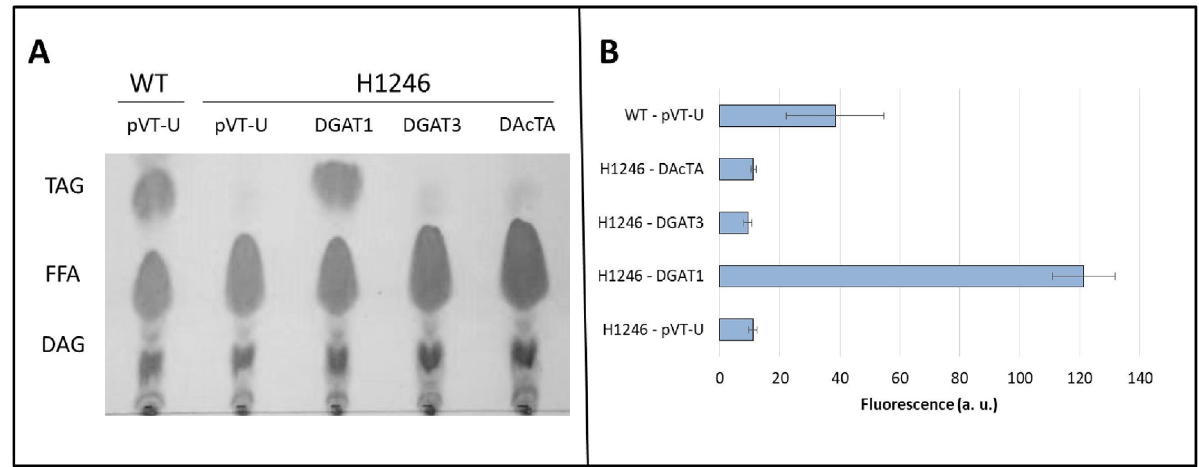
Figure 5 – Complementation assay using mutant yeast unable to produce oil. (A) Thin-layer chromatography (TLC) of total lipid extract of wild type yeast (WT) or TAG synthesis mutant yeast (H1246). Cells were transformed with empty pVT-103U (empty vector), or with the plasmid containing castor bean DGAT1 , DGAT3 or DAcTA CDS. Cells were grown in a minimum medium without uracil for 72 hours. (B) In vivo DGAT activity using Nile red stain in mutant yeast. TAG: Triacylglycerides; FFA: Free Fatty Acids; DAG: